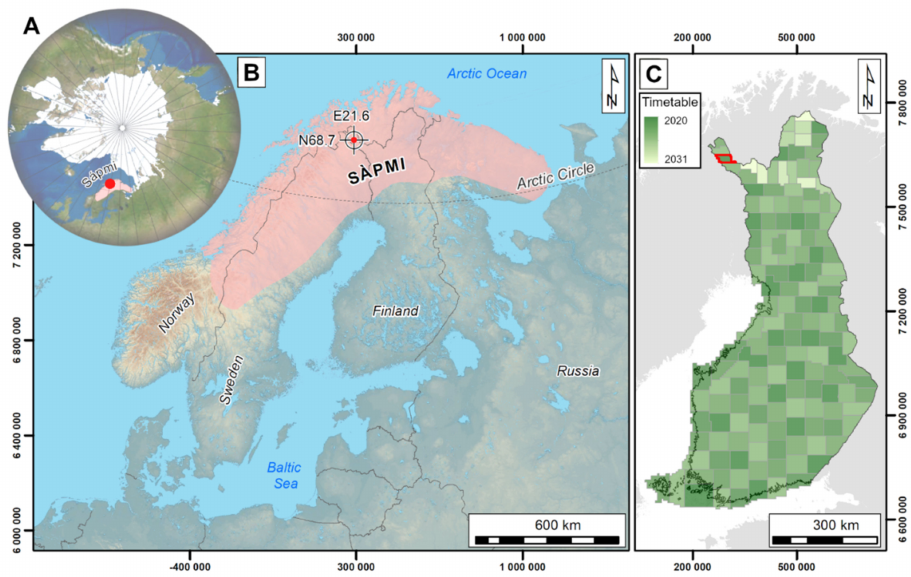
Figure 1. ( A , B ) Location of the Ropijärvenperä production area in S á pmi (Finnish Lapland), northernmost Europe (high- lighted with a red dot) (Background © Esri). ( C ) Finnish National Land Survey timetable for ALS-5p data collection, Ropijärvenperä with a red outline (EPSG:3879 ETRS89/GK25FIN). (Illustration: Oula